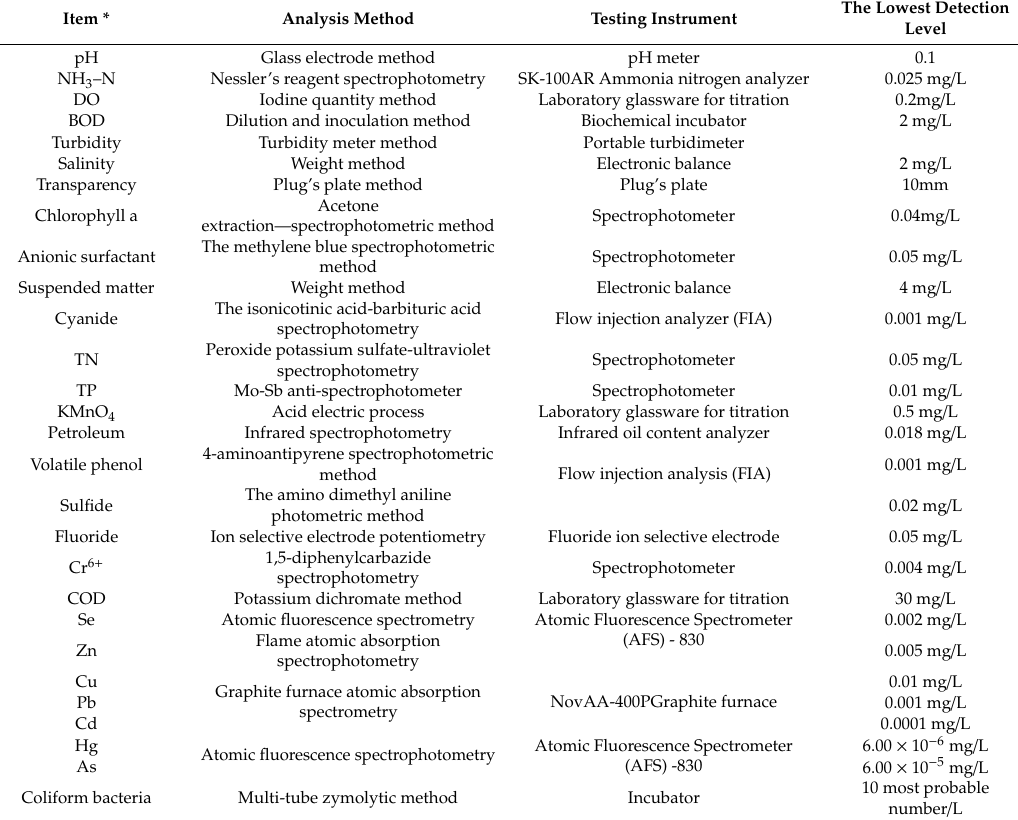
Table 1. Physical and chemical parameter analysis methods and detection